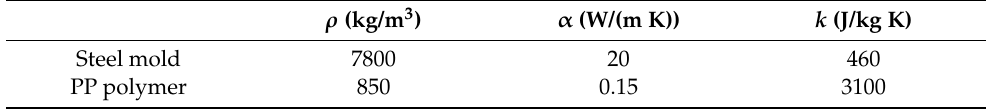
Table 1. Steel mold and PP polymer thermal material properties used in simulations.